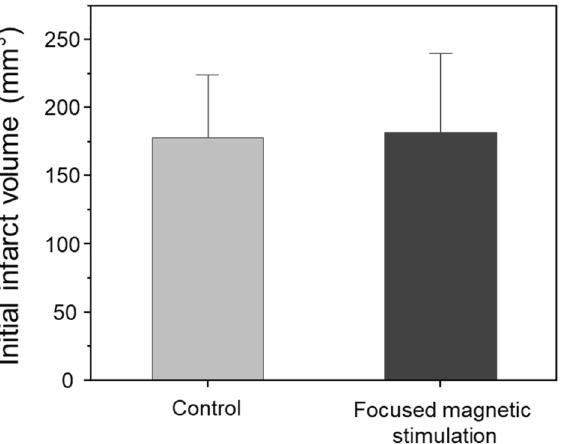
Figure 7. Initial infarct volume of stroke model prepared by MCAO method. The initial infarct size of stroke models prepared by the MCAO method was compared. The prepared stroke model (n = 15) was divided into a control group to which no magnetic heating was applied and a group to which focused magnetic heating was applied. Initial infarct size between the two groups showed no significant difference.